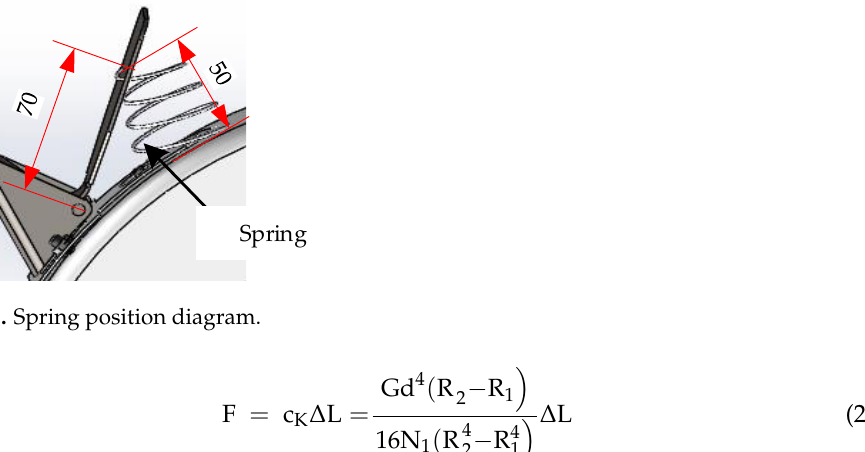
Figure 13. Spring position diagram.